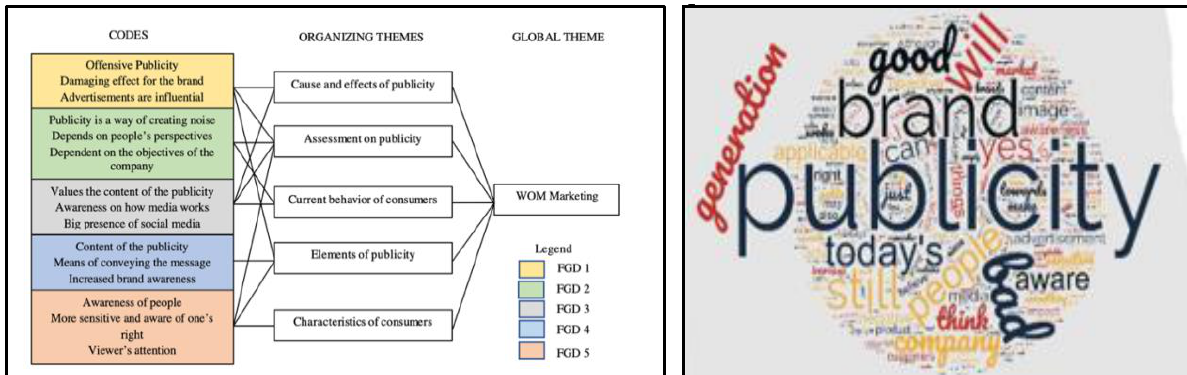
Figure 9: Concept Map of Applying the Notion “All Publicity is Still Good Publicity”